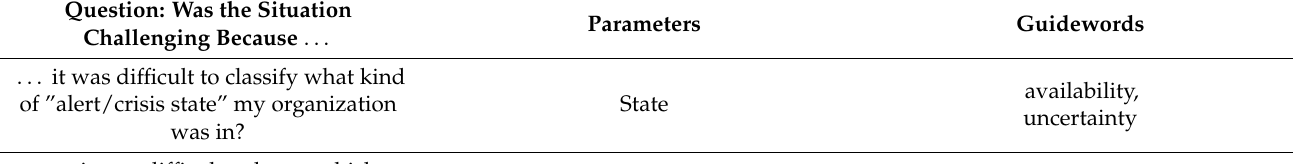
Table 3. Parameters, guidewords, and active verbs transformed into example questions exploring the problem space (crisis